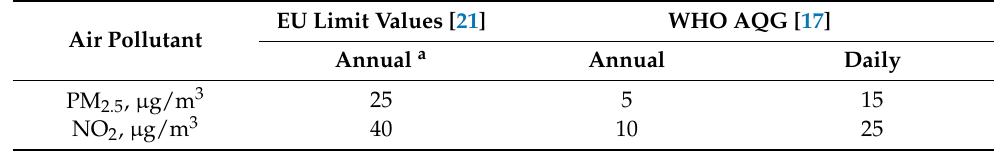
Table 1. EU limit values and WHO Air Quality Guidelines (AQG) for considered air pollutants. EU Limit Values Air Pollutant